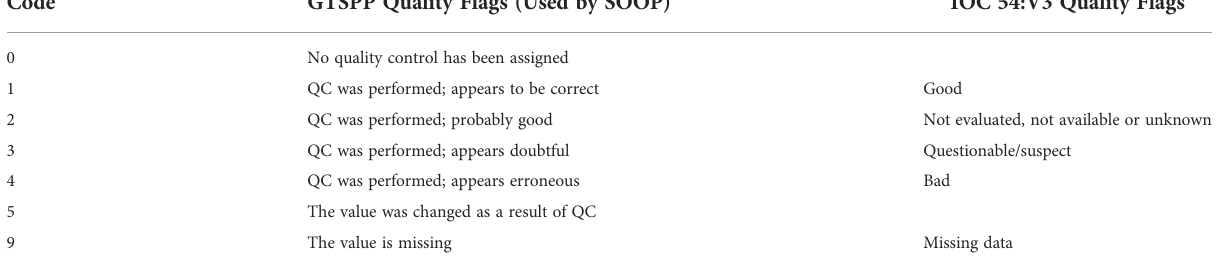
TABLE 1 Flagging Scheme Comparison.